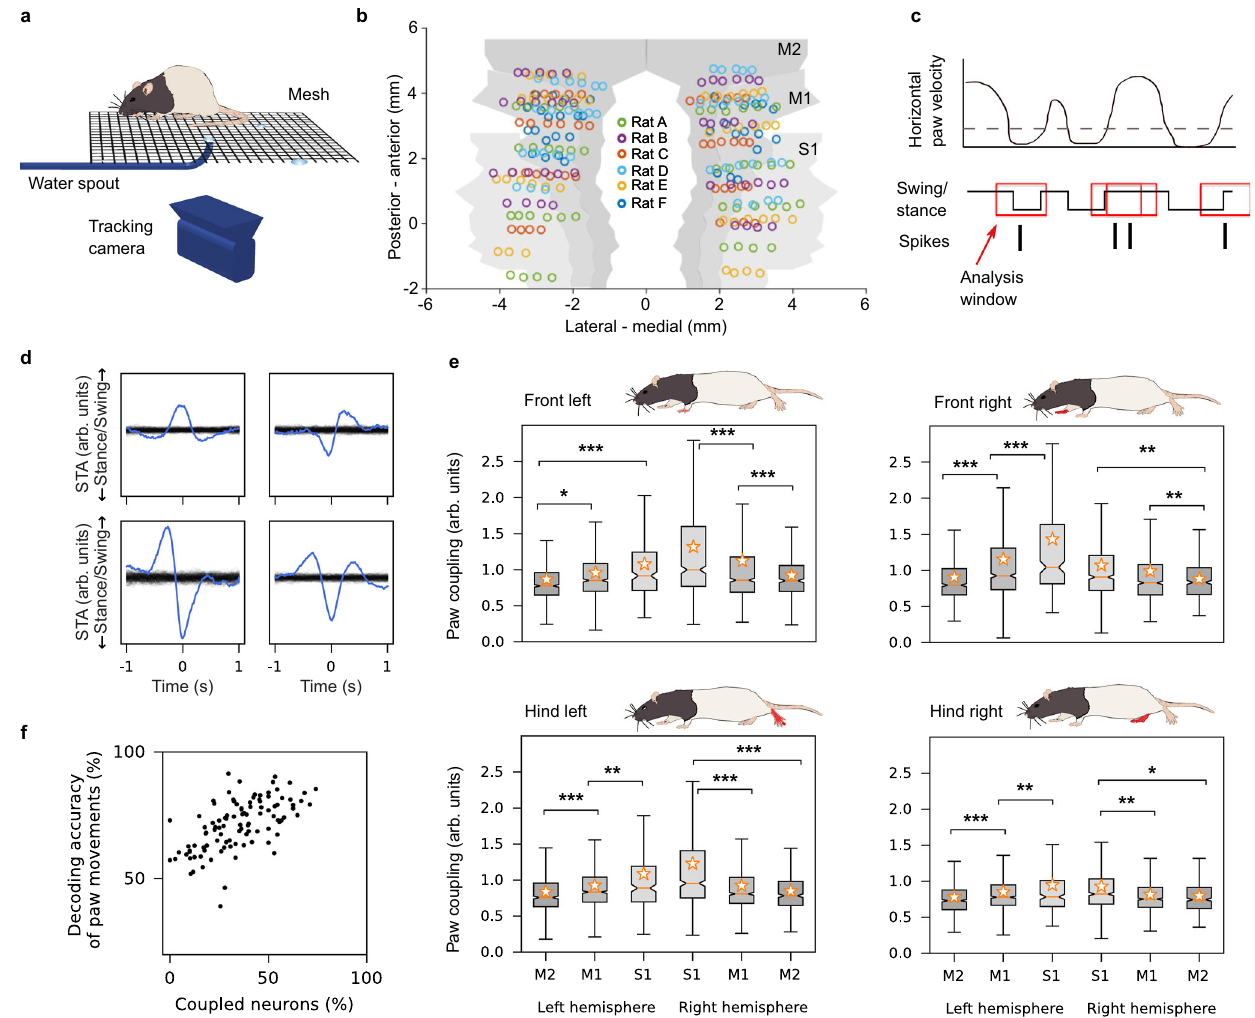
Fig. 1 | Spike-triggered average paw swing – stance status (STAPSSS) during unconstrained movements extracts lateralized paw coupling. a Behavioral setupwithaground mesh, camera, and robot arm delivering water drops, adapted from ref. 52. b Locations of the electrodes of the six implanted rats, adapted from ref. 52. c Paw movements were binarized into swing (moving) and stance (not moving).STAPSSSwascalculatedbyaveragingtheswing – stancestatusinwindows ±1s(indicatedwithredboxes)aroundeachspike. d STAPSSSfortherightfrontpaw of four example single-units in the left and right S1 (upper panel) and the left and right M1 (lower panel). Black lines refer to the statistical control waveforms. e Coupling for each paw, brain area, and hemisphere, averaged over neurons ( n =734, n =896, n =231 in left M2, M1, S1, and n =631, n =796, n =435 in right S1,